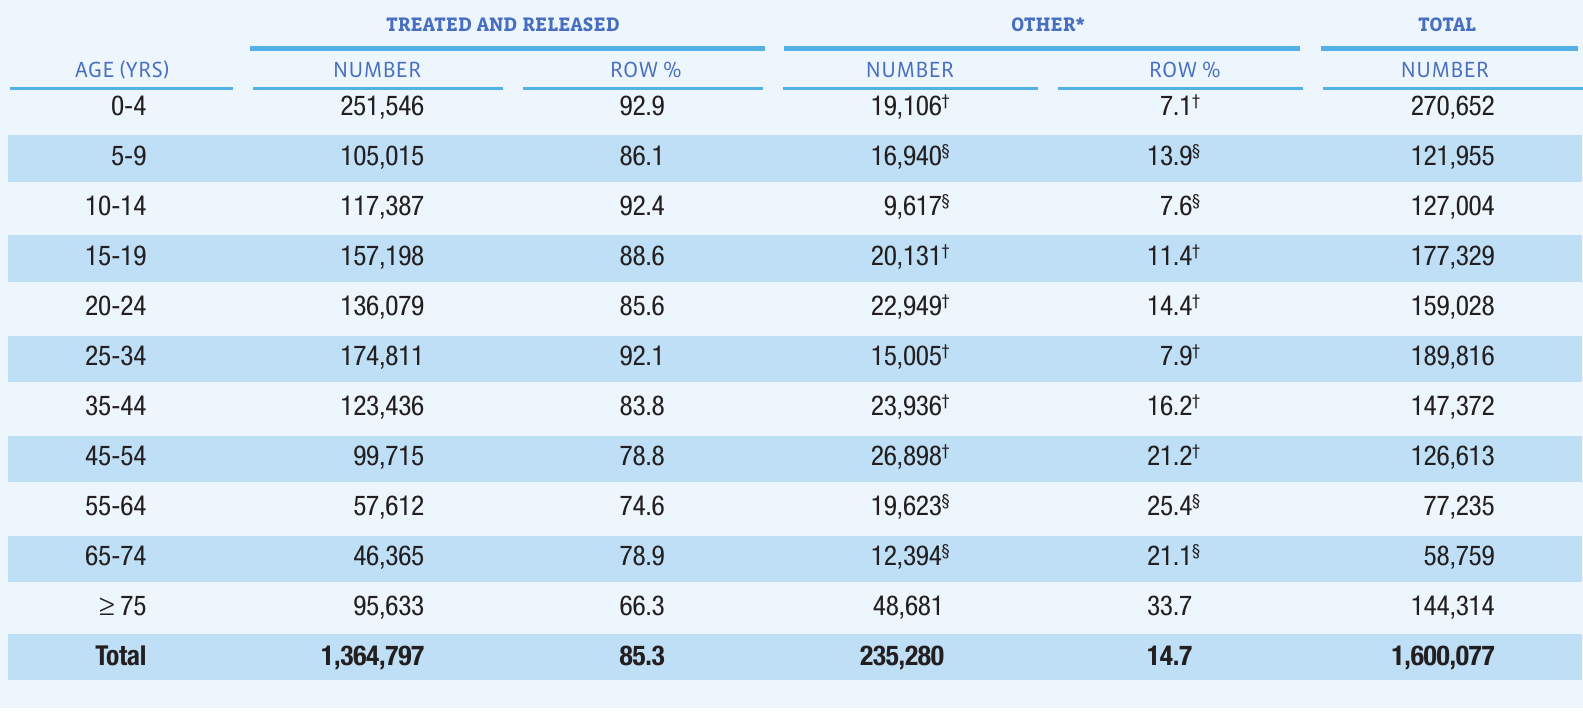
TABLE 2: Estimated Average Annual Numbers and Percentages of Traumatic Brain